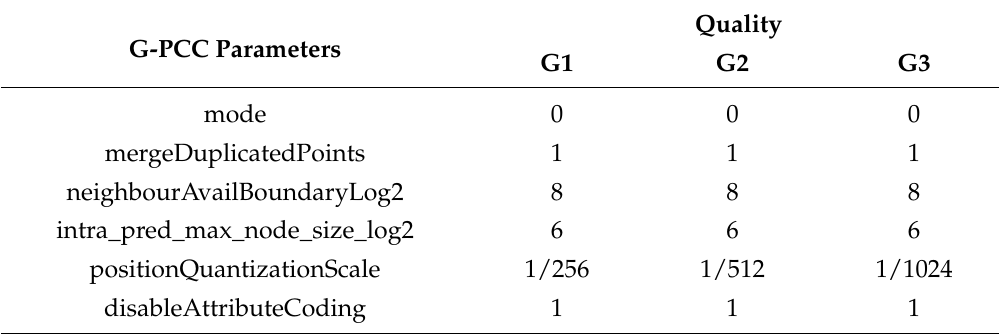
Table 1. MPEG G-PCC coder parameters used for qualities G1, G2 and G3.